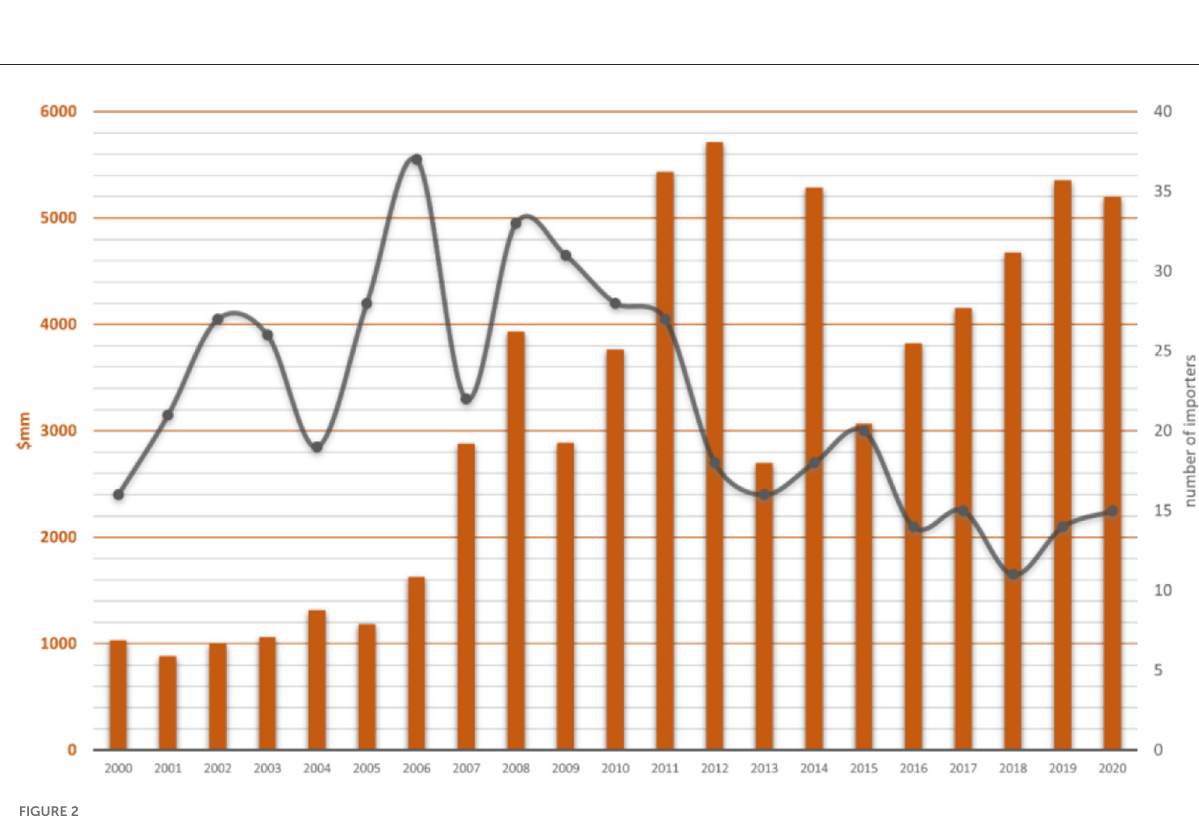
FIGURE2 Imports to Egypt (wheat, USD) 2000–2020. Source: Food and Agriculture Organization